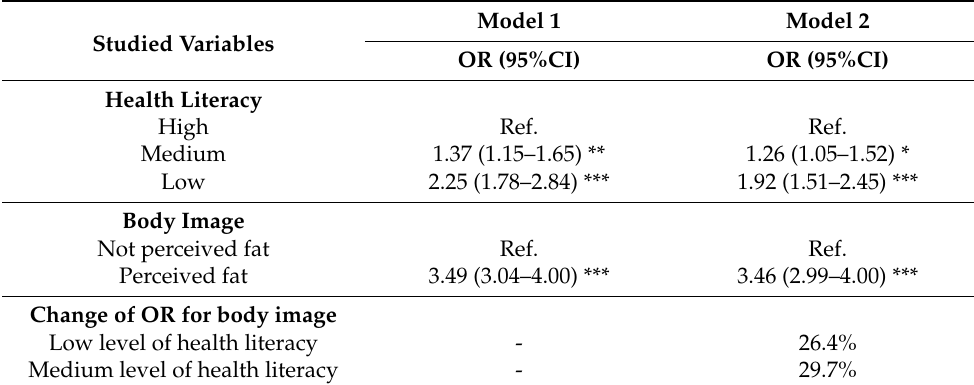
Table 2. The association of health literacy and symptoms of eating disorders, adjusted for age and gender, and additionally adjusted for body image from logistic regression models (odds ratio/95% confidence interval) (Slovakia 2018, 13–15-years-old, n =